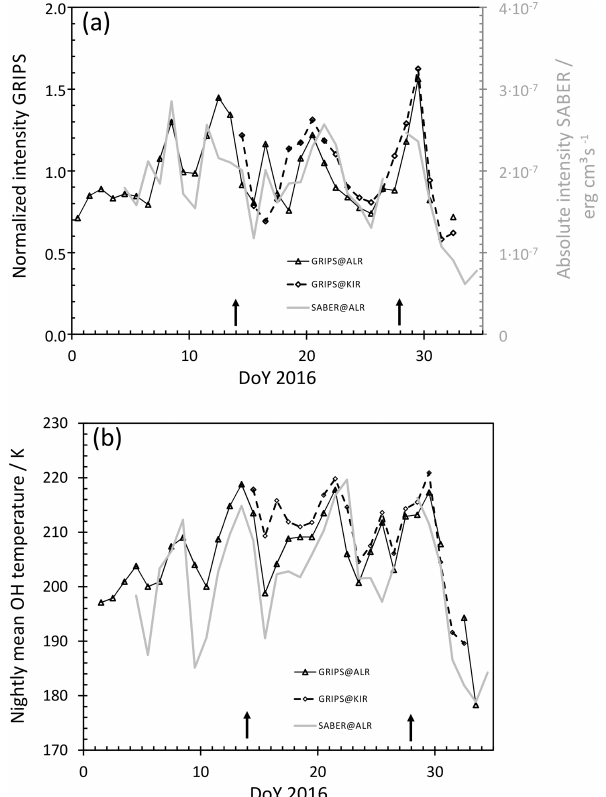
Figure 4. (a) Average airglow intensity during the GW-LCYCLE campaign, covered by the three instruments GRIPS 14 at ALO- MAR (solid, triangles), GRIPS 9 at Kiruna (dashed, diamonds), and SABER (grey) normalized to the respective mean intensity of the time period (1 January to 3 February 2016). The arrows mark the dates of flight 1 and 5. (b) Nightly mean OH temperatures at ALO- MAR (solid) and Kiruna (dashed). The temperature values agree within ca. 6K on average. This is 1 order of magnitude lower than expected for this latitude, distance, and season according to Fig. 5 from Wendt et al. (2013). The unit ”erg” is equal to 1 × 10 − 7 J. above, the weather situation at ALOMAR did not allow the derivation of gravity wave information there).